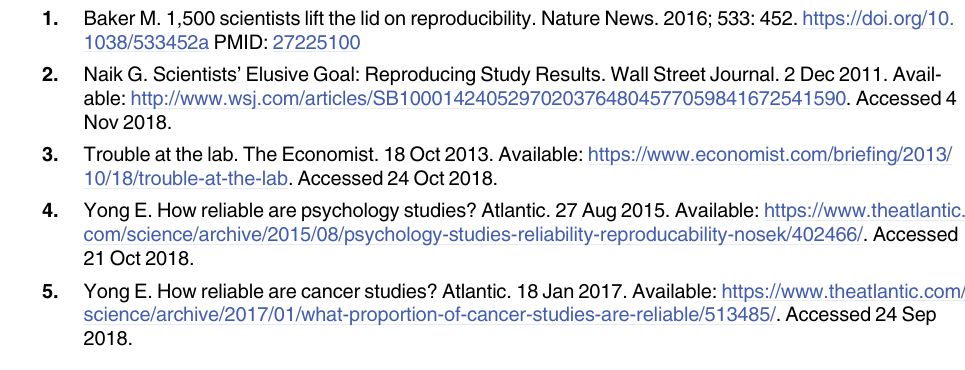
S2 Table. Percentage share of the mean article profile, coordinates, contribution, and cos 2 for all themes included in the correspondence